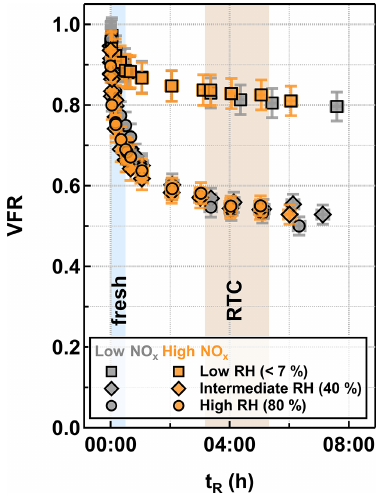
Figure 1. Volume fraction remaining (VFR) derived from particle size measurements as function of residence time ( t R ) in the RTCs for α -pinene SOA particles which were formed under low NO x (gray) and high NO x (orange) conditions in the OFR and evaporated under low RH ( < 7%RH; squares), intermediate RH (40%RH; diamonds), and high RH (80%RH; circles) conditions. The blue and brown areas indicate the collection periods of FIGAERO-CIMS corresponding to fresh and RTC